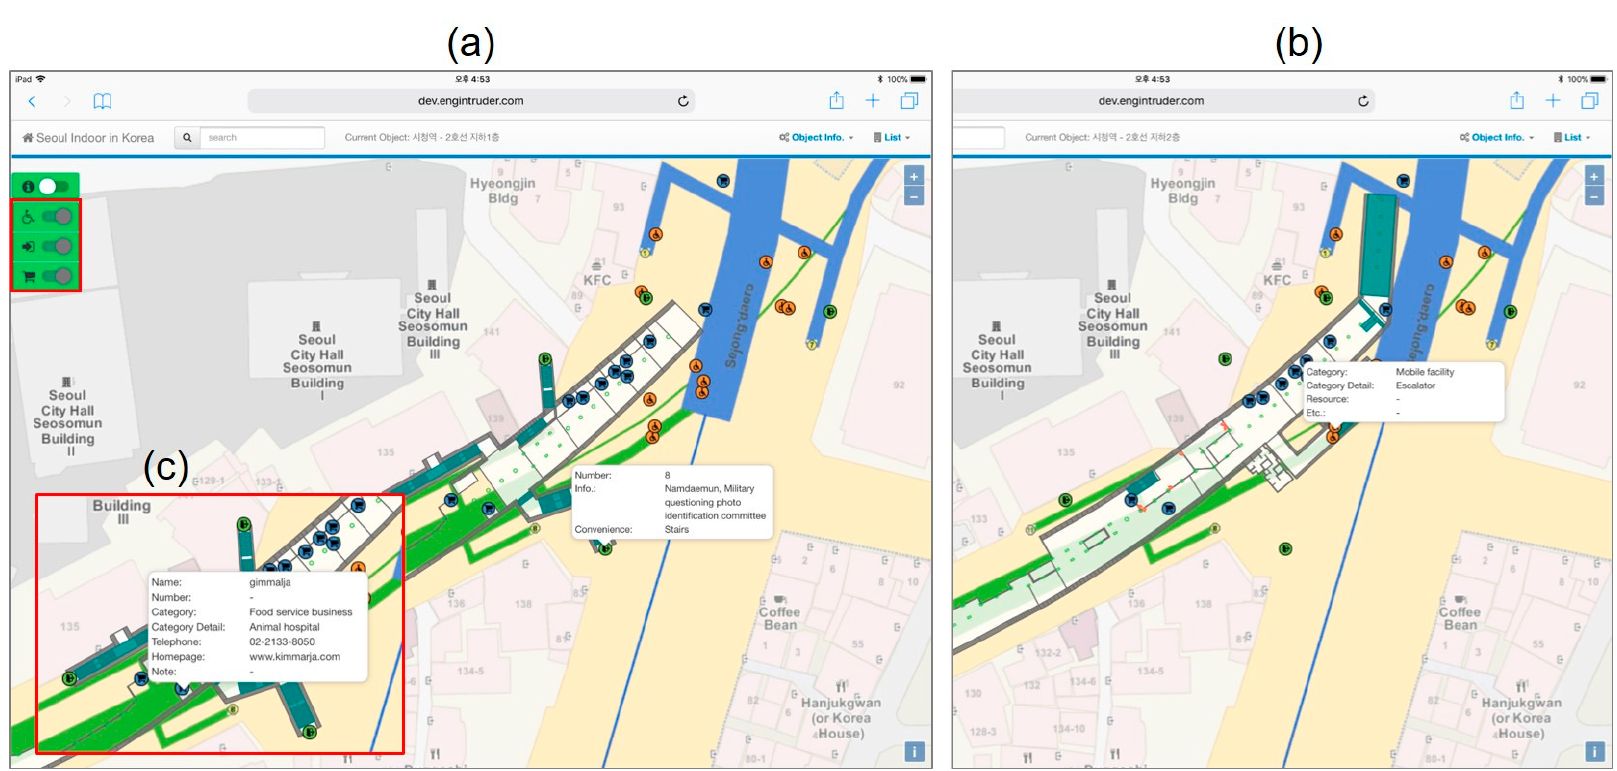
Figure 11. Visualization results of indoor POI detailed information: ( a ) entrance, ( b ) handicap facility, and ( c ) shopping center.